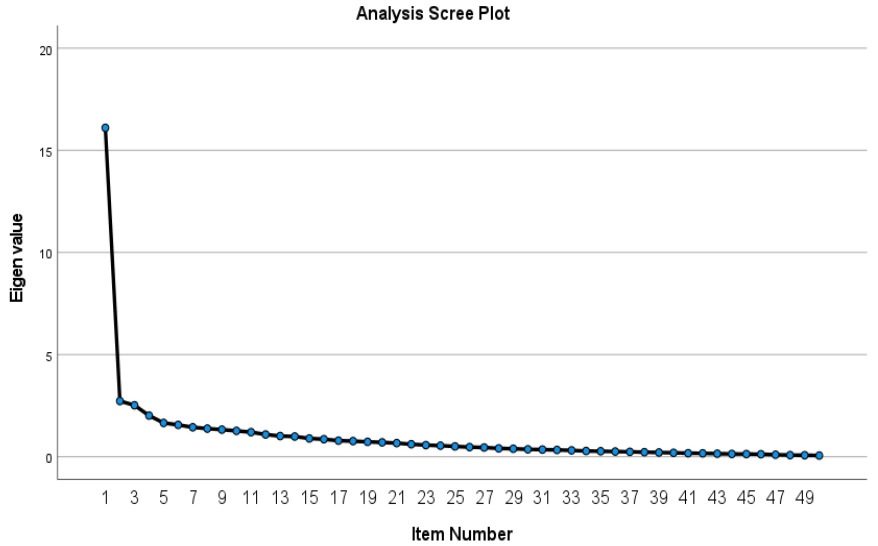
Figure 1. Analysis Scree Plot.